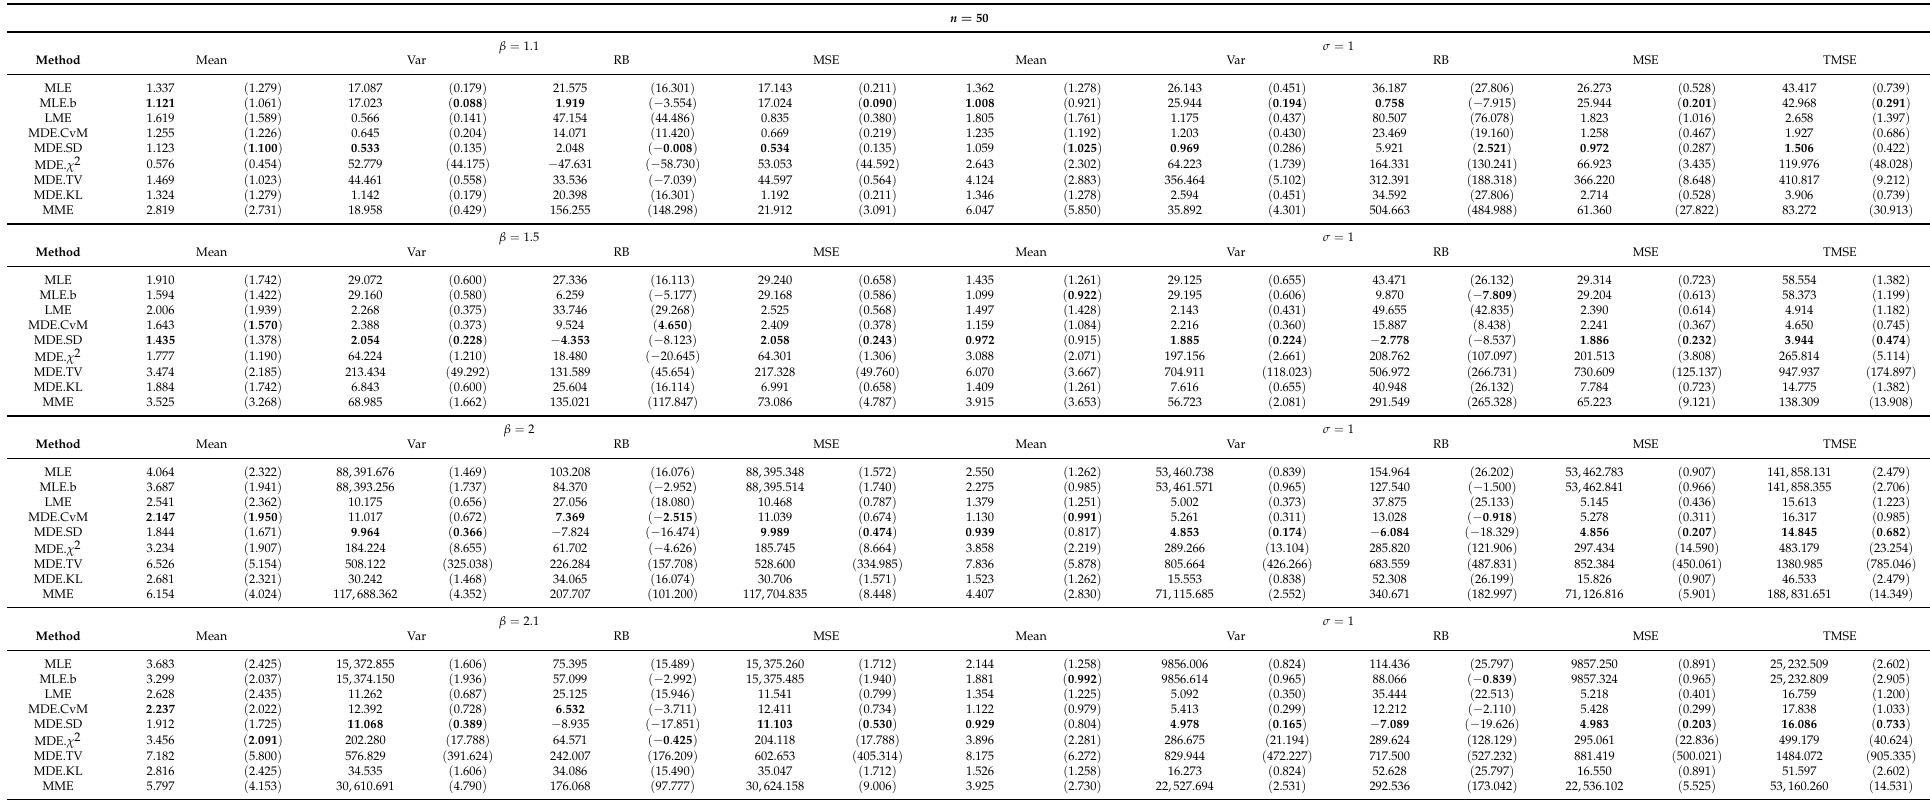
Table 3. Comparison of different estimation methods for different values of β ( σ = 1 and n =